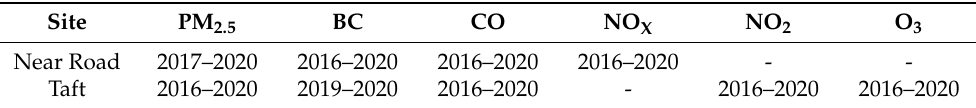
Table 1. Years each pollutant was analyzed. Not all pollutants were analyzed from 2016 through 2020 at both sites due to a lack of data